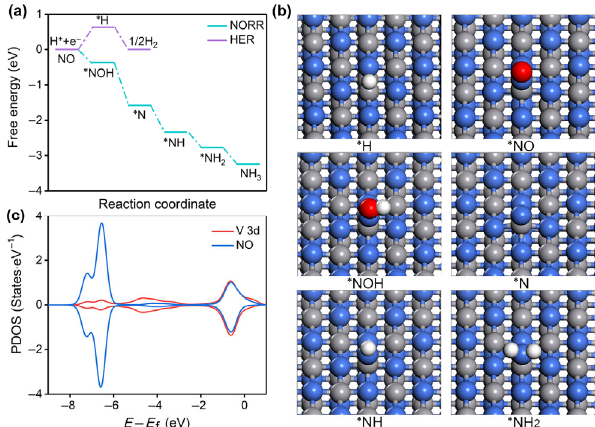
Figure 4 DFT calculations. (a) Calculated free energy diagrams for HER and NORR pathways on VN (200). (b) Geometries of the intermediates for HER and NORR; V: gray, N: light blue, O: red, and H: white. (c) Local projected DOS (PDOS) of the adsorbed NO and its bonded V